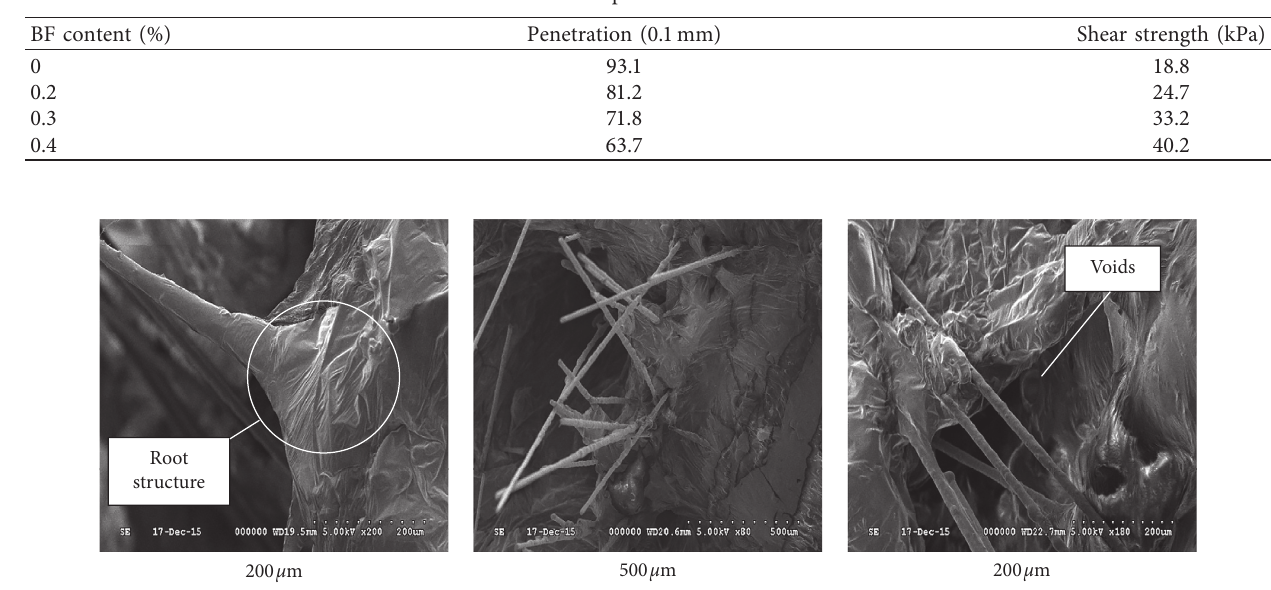
Table 8: Cone penetration test results.